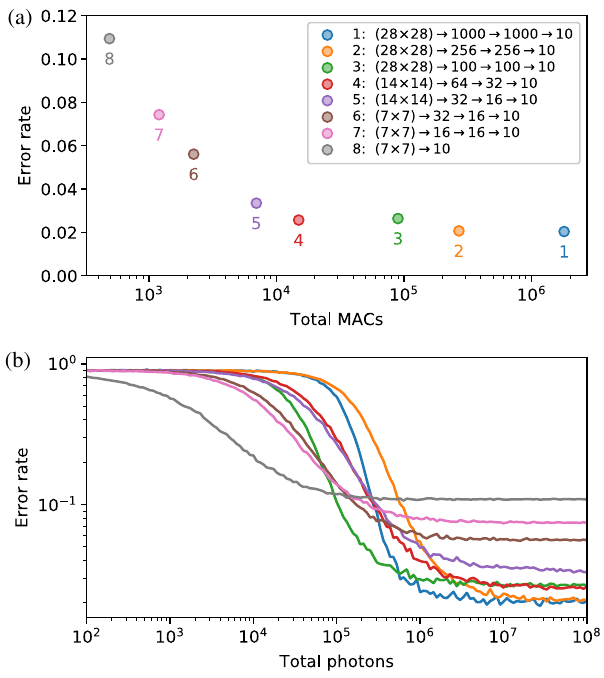
FIG. 5. Contributions to energy budget. SQL dots corres- pond to minimum E required to make the error rate MAC p ð E Þ < 1 . 5 p ð ∞ Þ [error bars correspond to p err MAC err ½ 1 . 2 ; 2 . 0 (cid:3) p ð ∞ Þ ]. E ¼ n ð hc= λ Þ , λ ¼ 1 . 55 μ err MAC MAC